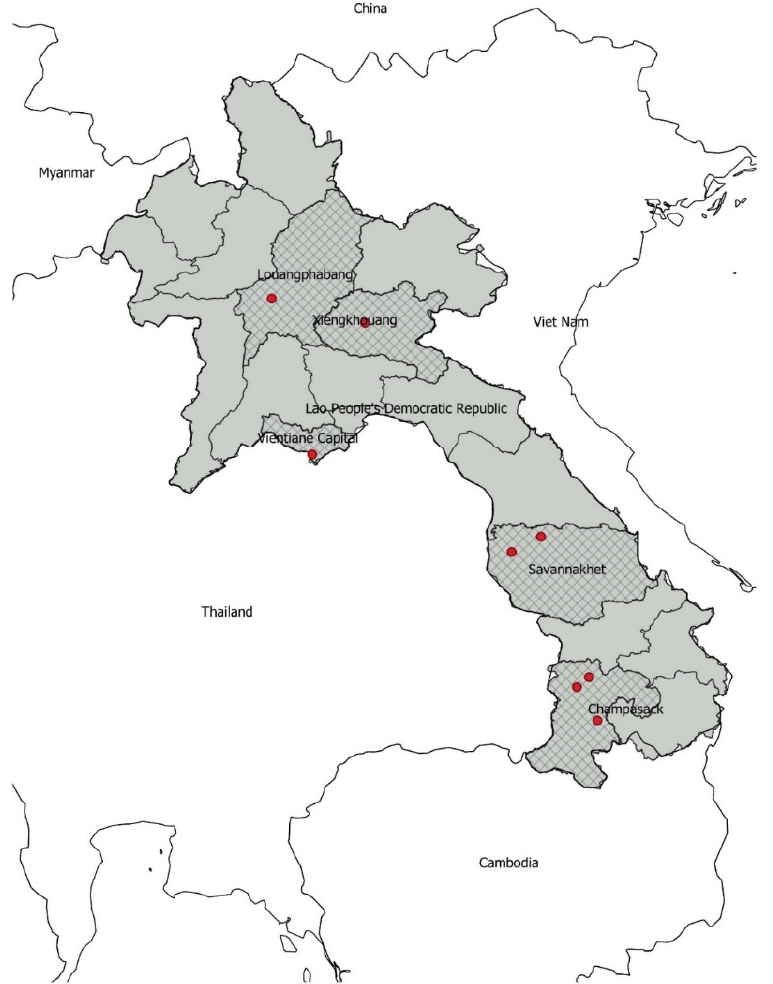
Figure 1. The Lao People’s Democratic Republic (grey) and its neighboring countries; also shown: the location of the 8 districts (red dots) in 5 provinces where the sampling was conducted.